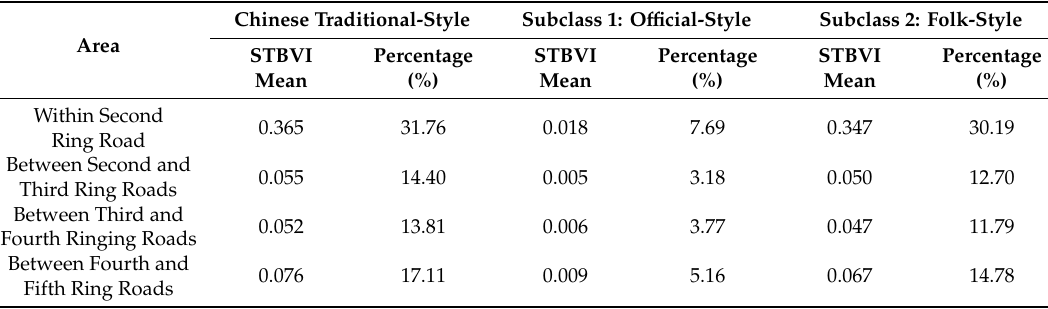
Figure 11. Spatial distribution of the STBVI of the folk-style buildings. Table 6. STBVI statistics of the Chinese traditional-style buildings and its two subcategories.